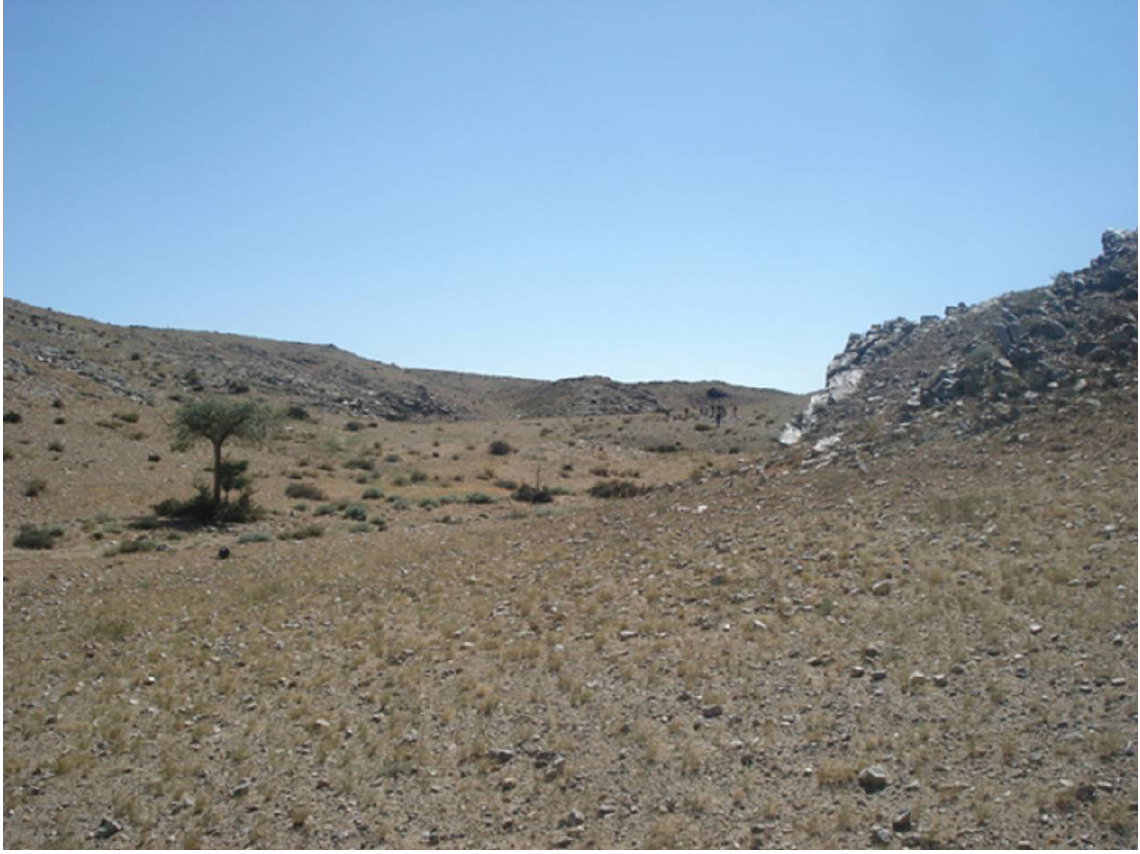
Figure 4. Typical Ikh Nart landscape with small trees along the course of an ephemeral